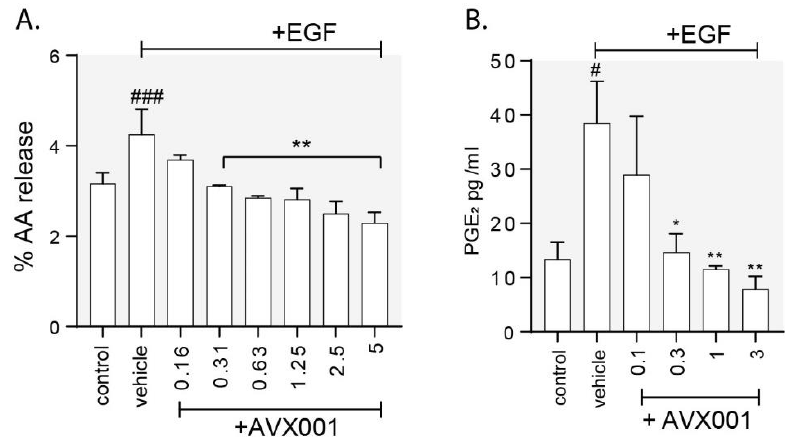
Figure 2. Effect of cPLA 2 α inhibition on epidermal growth factor (EGF)-dependent arachidonic acid (AA) and PGE 2 release. ( A ) AA release was measured by the [3H]-arachidonic acid release assay in HaCaT treated with AVX001 and stimulated with EGF (100 ng/mL, 60 min). Data are the mean ± SD for three replicates from a representative experiment repeated twice. ( B ) PGE 2 levels measured in the supernatant of cells preincubated with AVX001 at the indicated concentrations and stimulated with EGF (30 ng/mL, 24 h). Data are mean ± SEM for three replicates. Statistical significance was calculated by one-way ANOVA with Dunnett’s post-analysis; # p < 0.05, ### p < 0.005 versus unstimulated control and * p < 0.05, ** p < 0.01 versus vehicle-treated